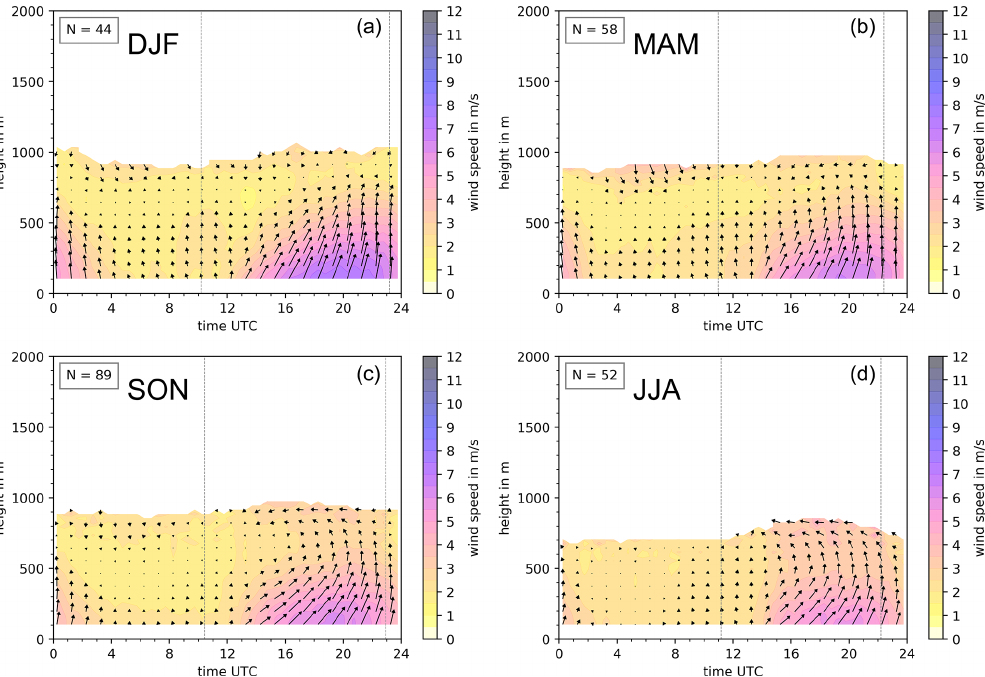
Figure 3. Mean horizontal wind speed (shading, length of arrows) and wind direction (arrows) during different seasons as a function of time of day and height. Clockwise: (a) austral summer (DJF), (b) fall (MAM), (d) winter (JJA) and (c) spring (SON). The value of N gives the number of days analyzed. Vertical dashed lines indicate the average times of sunrise and sunset. Night appears on the left-hand side and day on the right-hand side of each